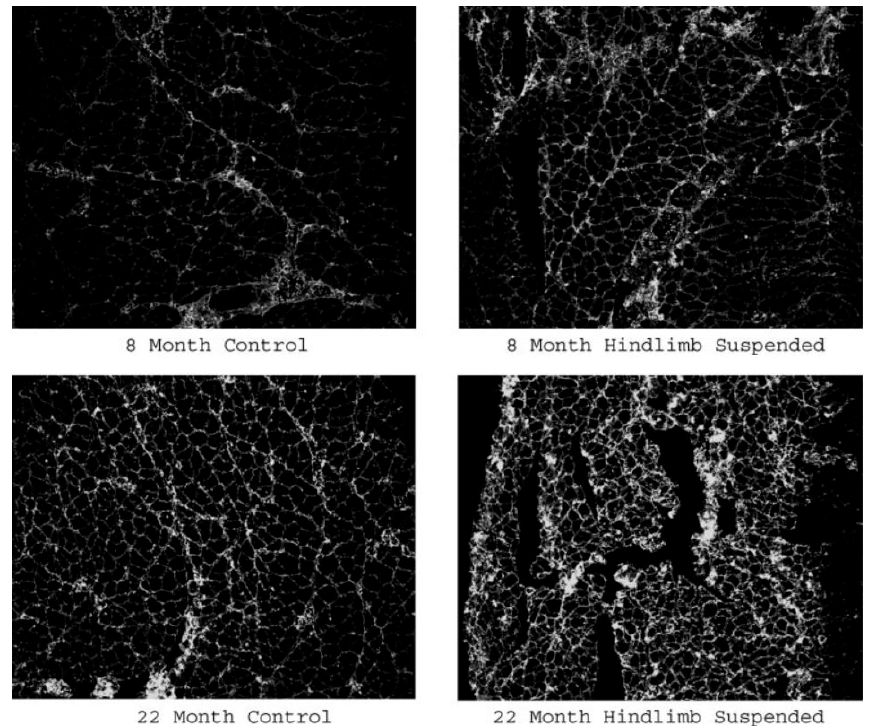
Figure 5. NCAM expression of aged (22 mo) and young adult (8 mo) muscle fibers under either control or unweighted (hindlimb suspended) conditions. Note that the NCAM expression is greatest in aged, unweighted fibers. Source: Deschenes and Wilson (2003).